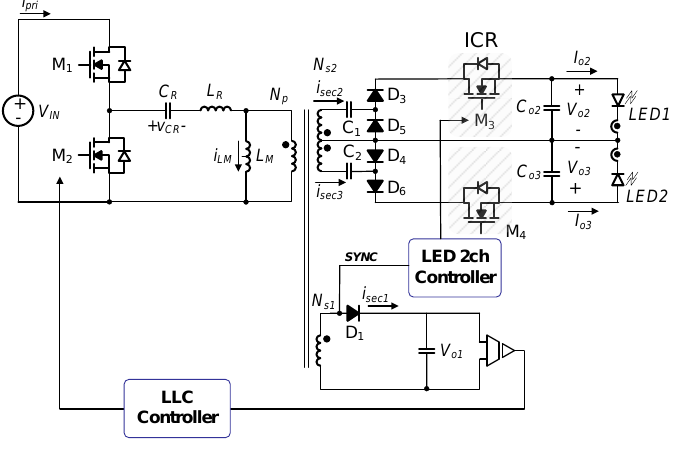
Figure 2. Proposed converter schematic.